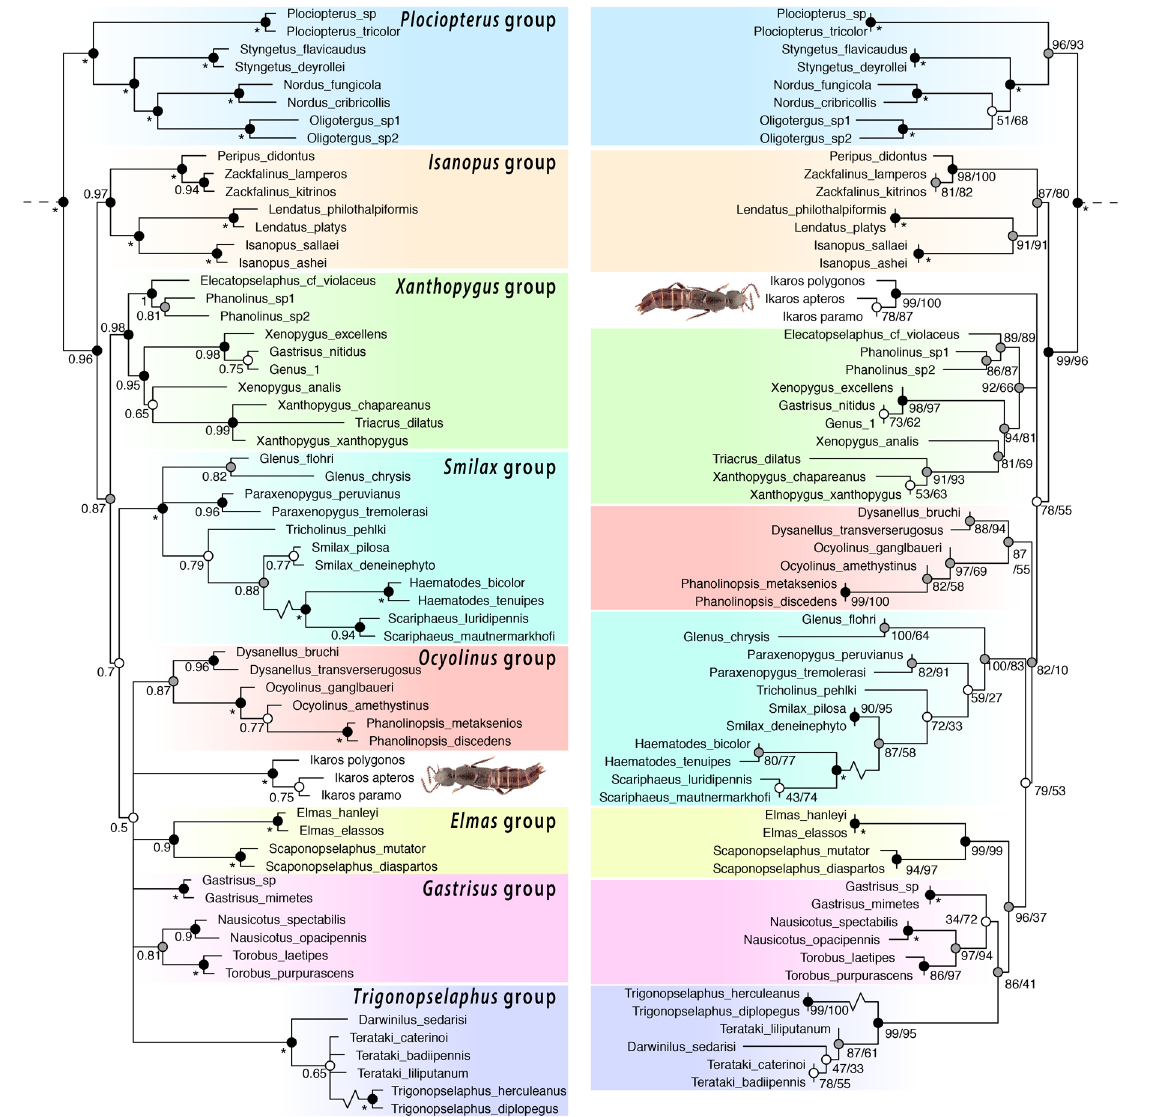
Fig. 1. Position of Ikaros gen. nov., based on partitioned, total evidence phylogenetic analyses of six genes and morphology (all characters), using Bayesian (left) and maximum likelihood (ML) (right), with outgroups removed for visualization. Posterior probabilities (Bayesian) are given to the left of the corresponding node, and SH-aLRT (left) and ultrafast bootstrap (UFB) (right) (ML) values are given to the right of the corresponding node. Nodes colored based on support: PP ≥ 0.90, UFB ≥ 95 and SH-aLRT ≥ 80 = black; PP = 0.80–0.89, one of UFB < 95 or SH-aLRT < 80 = grey; PP < 0.80, both UFB < 95 and SH-aLRT < 80 =